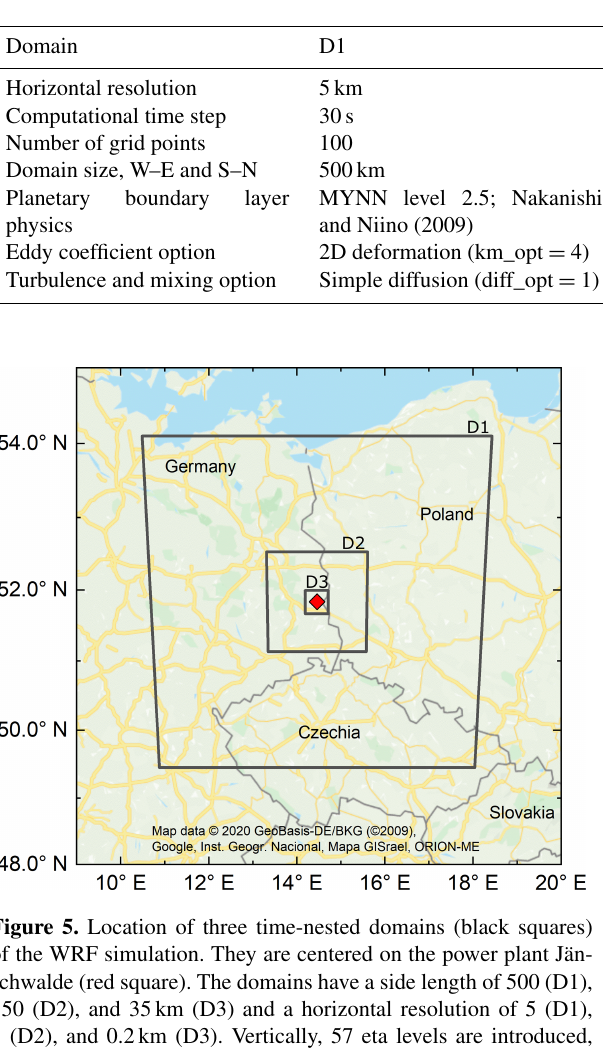
Table 3. Configuration of quadratic domains.